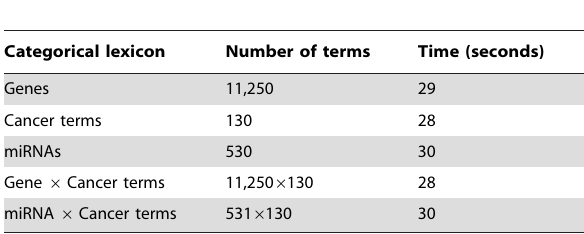
Table 2. Query times for batch queries on PubMed abstracts with gene, miRNA and/or cancer term lexicons.